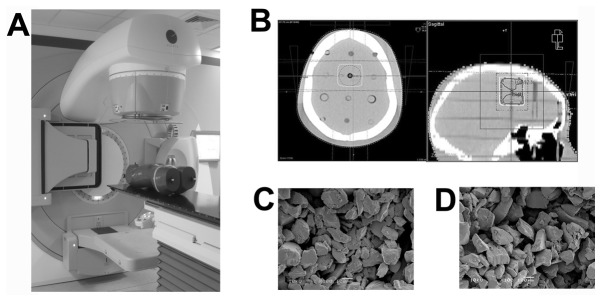
Effect of clinically-relevant radiotherapy regime on PLGA/PEG microparticle-based matrices.(A) PLGA/PEG matrices (12mm x 6mm) were placed within cavities in the brain area of an anthropomorphic phantom. (B) A head computerized tomography was obtained (3mm slices) using a standard radiotherapy protocol and the computerized tomography transferred to a radiotherapy planning system to give a uniform standard isocentric three field 60 Gy dose (30 daily 2 Gy fractions) of radiation to the biomaterial and surrounding area. (C) Scanning electron microscopy of control non-irradiated matrices kept at room temperature for 30 days, showing distinct and structurally intact microparticles with visible pores between particles. (D) Scanning electron microscopy of irradiated matrices showing no obvious difference in matrix microstructure (scale bar 100µm).